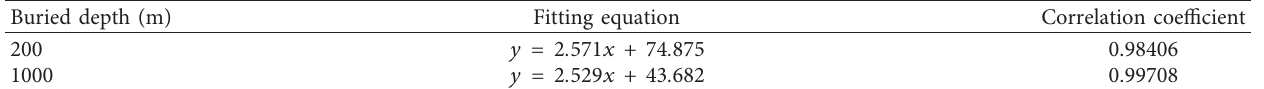
Table 3: Relationship between peak strength and confining